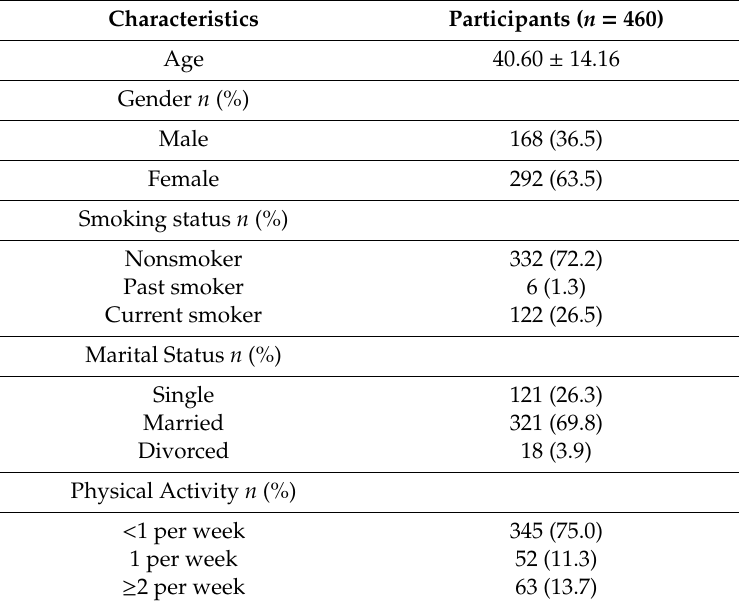
Table 1. Demographic characteristics of the study participants.